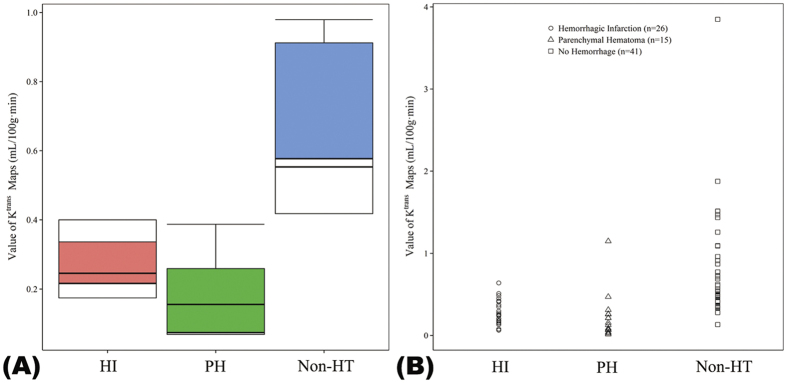
Box plots and distribution of Ktrans values in different regions.(A) Box plots of Ktrans values in hemorrhagic infarction (HI), parenchymal hemorrhage (PH) and non-hemorrhagic transformation (Non-HT) regions. In each box, the median, 95% confidence interval (CI), and first and third quartile values are illustrated. (B) The distribution of Ktrans values grouped into HI, PH, and Non-HT regions.